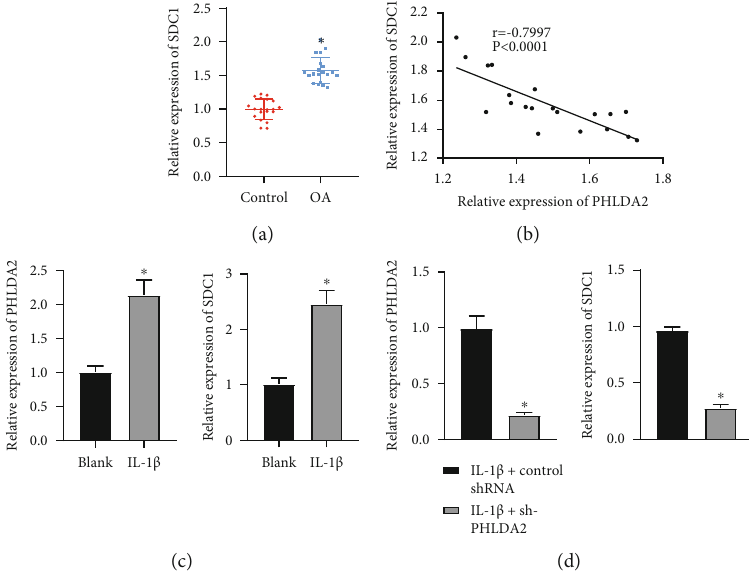
Figure 5: PHLDA2 elevates SDC1 expression. (a) SDC1 mRNA level in the cartilage tissues of OA patients ( n = 20 ) and patients with traumatic amputation ( n = 20 ) determined by RT-qPCR. (b) Correlation between PHLDA2 and SDC1 analyzed by Pearson ’ s correlation coe ffi cient. (c) Expression of PHLDA2 and SDC1 in IL-1 β -induced chondrocytes determined by RT-qPCR. (d) Expression of PHLDA2 and SDC1 in IL-1 β -induced chondrocytes transduced with sh-PHLDA2 determined by RT-qPCR. ∗ p < 0 : 05 vs. patients with traumatic amputation; chondrocytes without treatment, or chondrocytes treated with IL-1 β +control shRNA. Data are shown as the mean ± standard deviation of three technical replicates. Data between two groups were compared by independent t